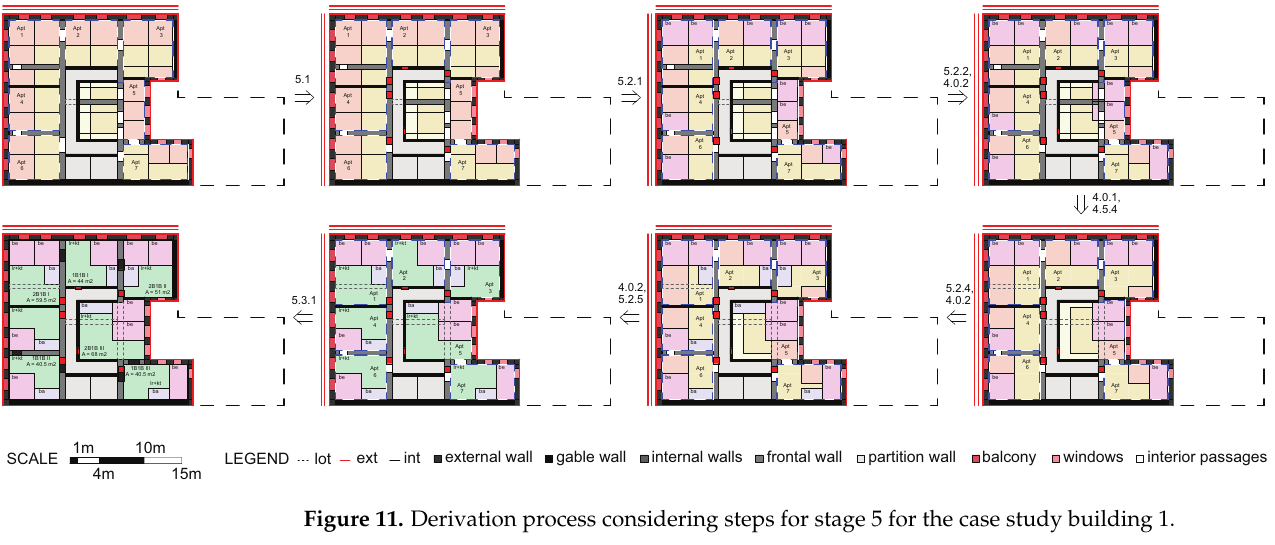
Figure 11. Derivation process considering steps for stage 5 for the case study building 1.